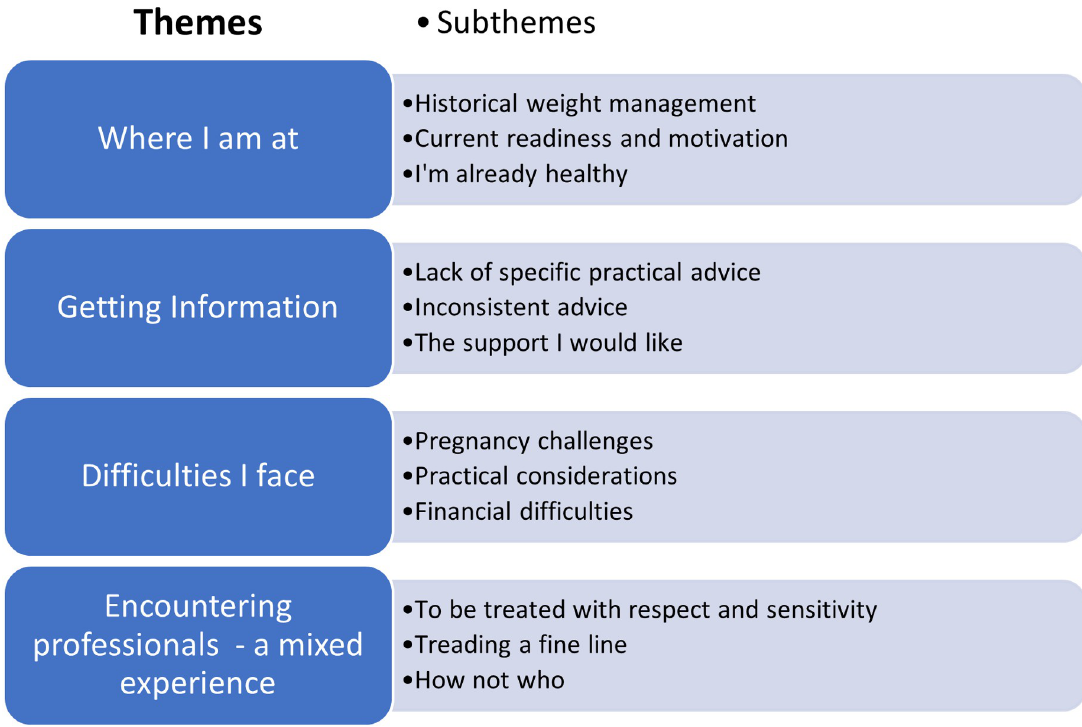
Fig 1. Themes and subthemes within the